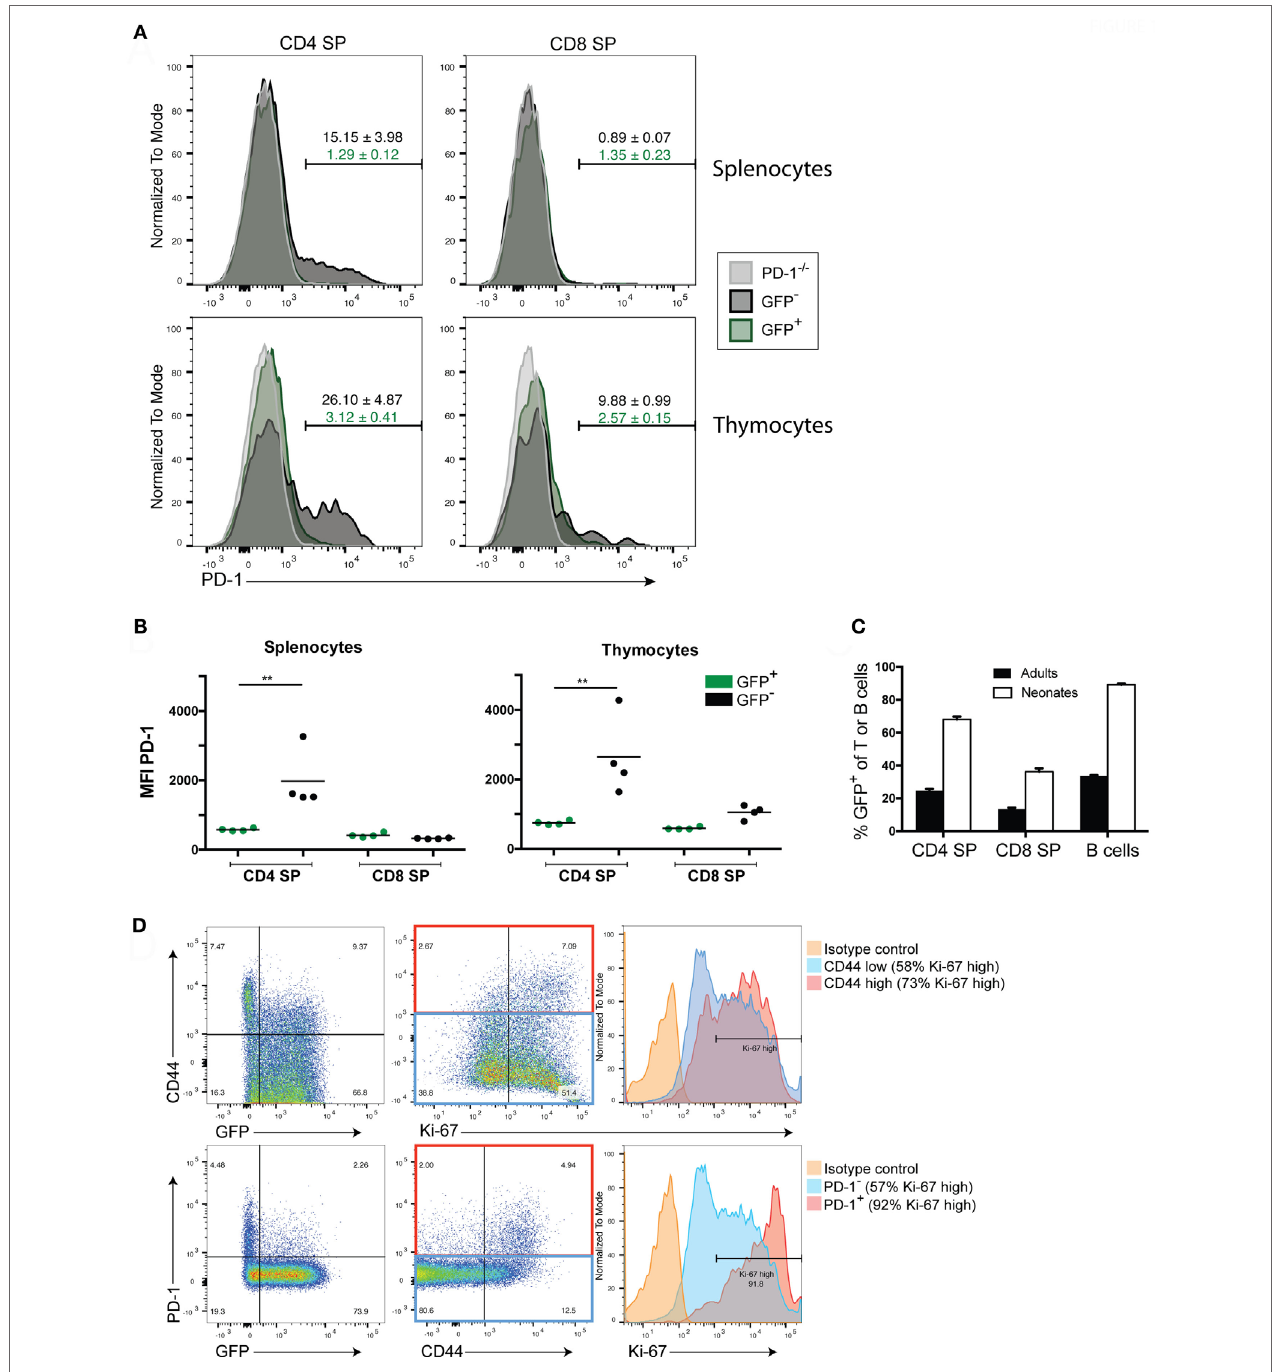
FigUre 1 | Newly generated T cells in adults lack programmed death-1 (PD-1) expression while in neonates their expression of PD-1 is linked to LIP . (a) Representative flow cytometric analysis of splenocytes and thymocytes from 10- to 12-week-old adult Rag2pGFP mice for PD-1 expression among TCR β + CD4 or CD8 single positive (SP) cells that are GFP + (newly generated T cells) or GFP − (mature cells). T cells from PD-1 − / − mice were also stained as a control for background. Values above gates are the group average %PD-1 positive cells within the mature GFP − population (black text) or GFP + population (green text), ± SEM. (B) Mean fluorescence intensity (MFI) of PD-1 staining in CD4 or CD8 SP, GFP + or GFP − T cells from Rag2pGFP splenocytes or thymocytes from the experiment depicted in (a) . ** p < 0.01, one-way ANOVA with Tukey’s multiple comparison test. (c) Comparison of percent GFP + cells among peripheral splenocytes in the indicated cell populations in adult vs. neonatal mice ± SEM. n = 8 per group. (D) Representative ( n = 3) flow cytometry plots of the indicated markers in splenic TCR β + CD4 SP T cells from 10-day-old Rag2pGFP neonates. Histogram (right) analyses of Ki-67 on CD44 high or PD-1 high cells and CD44 low/negative cells or PD-1 low/negative cells employed gates as shown in the red and blue rectangles (middle dot plots), respectively. Data presented are from samples that were either permeabilized and stained with antibodies to TCR β , CD4, CD8, PD-1, CD44, and Ki-67, or non-permeabilized and stained with antibodies to TCR β , CD4, CD8, PD-1, and CD44 (to allow analysis of GFP).